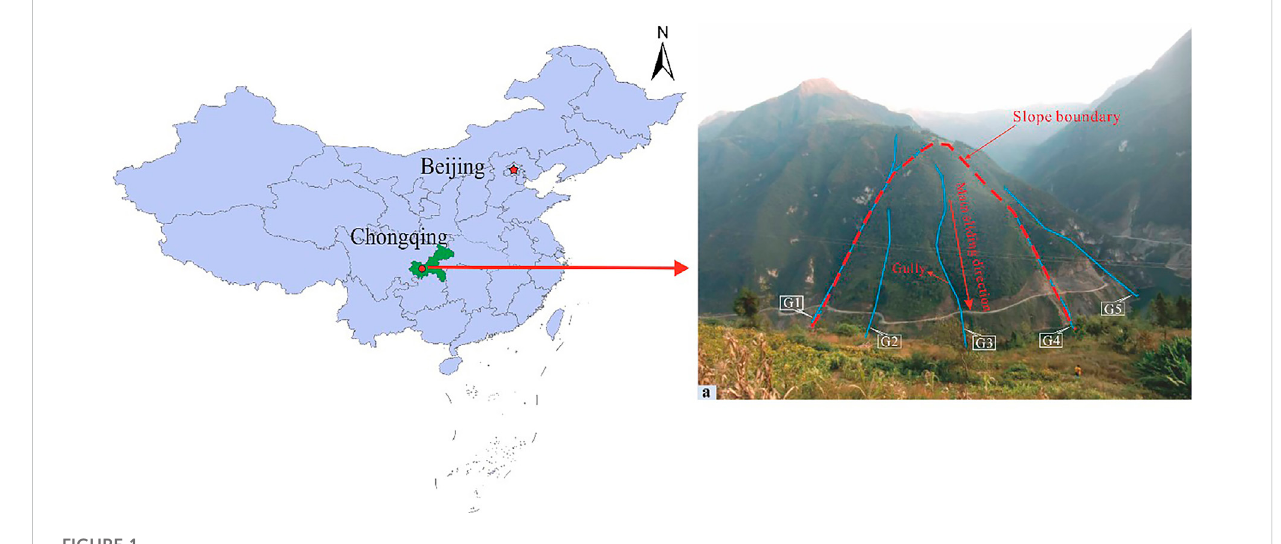
FIGURE 1 The whole landscape of the bank slope.